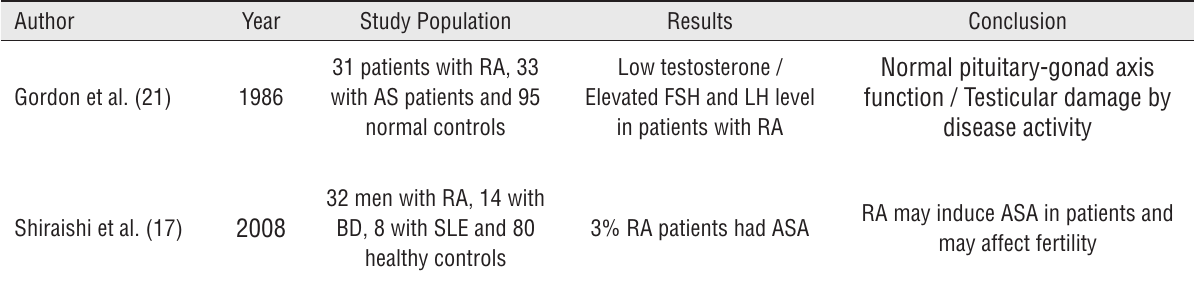
Table 3 - Rheumatoid arthritis and male fertility.